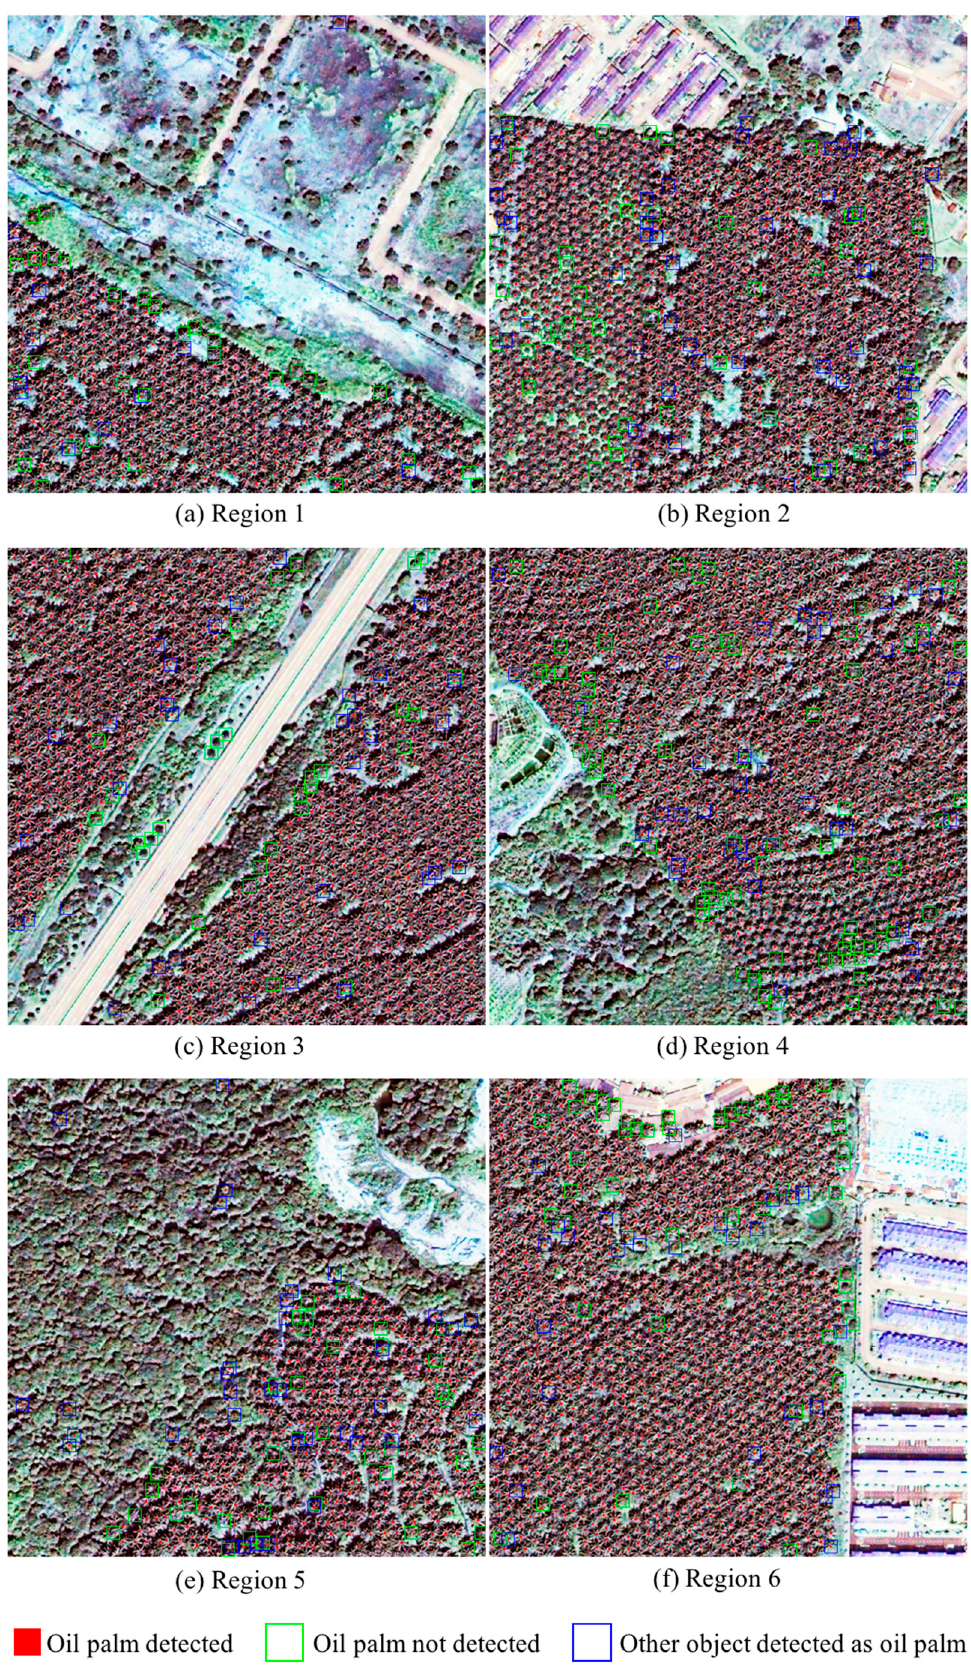
Figure 6. The image detection results of TS-CNN-based method ( a – f ) in six selected regions.